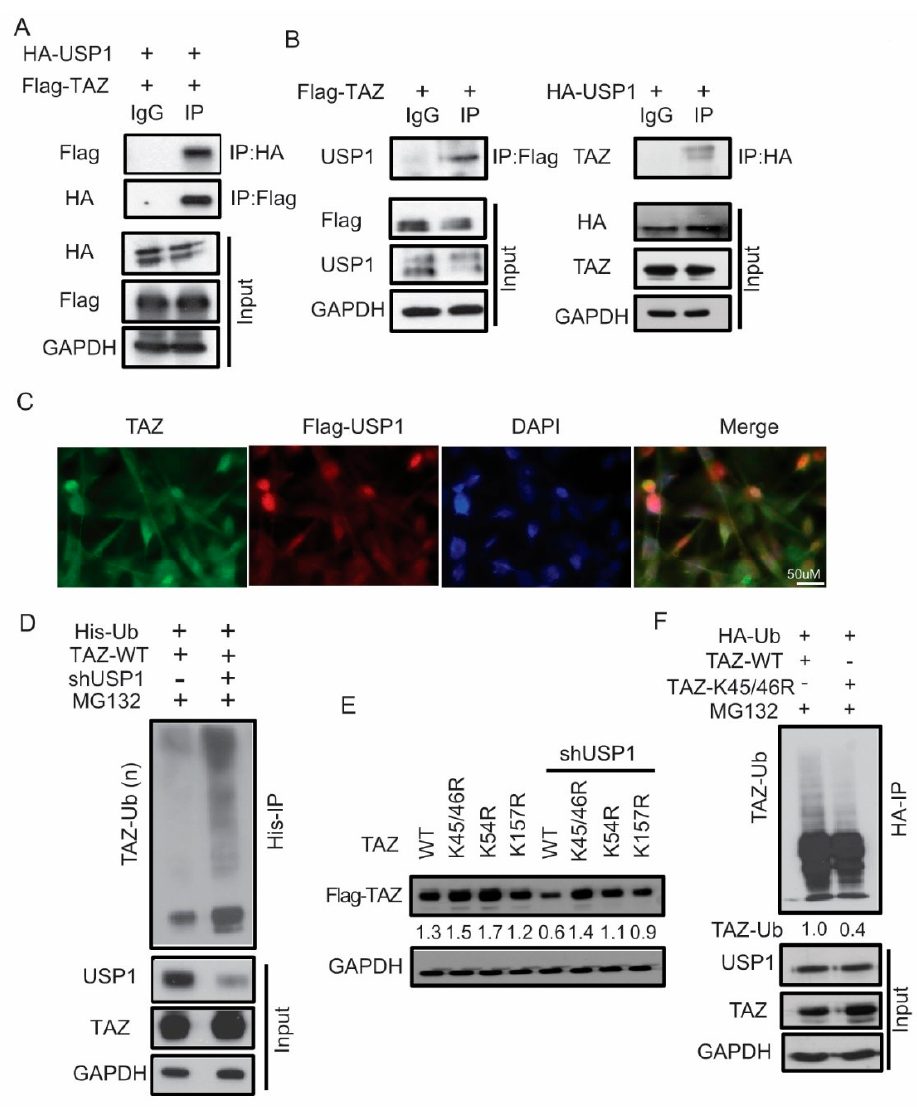
Figure 3. USP1 and TAZ form a complex and alters TAZ ubiquitination. ( A ) Interaction between exogenous USP1 and TAZ in 293T cells. Cellular extracts were immunoprecipitated with Flag or HA beads and probed for antibodies against indicated proteins. GAPDH was used as a loading control. ( B ) Interaction between exogenous TAZ and endogenous USP1 or exogenous USP1 and endogenous TAZ. GAPDH was used as a loading control. ( C ) Immunofluorescence staining of Flag-USP1 and TAZ in MDA-MB-231 cells (Scale bar = 50 µ m). ( D ) Increased ubiquitination of TAZ upon knockdown of USP1 and immunoprecipitation with His-beads. GAPDH was used as a loading control for input. ( E ) Immunoblot analysis of TAZ-WT or lysine mutants in the presence or absence of USP1. GAPDH was used as a loading control. ( F ) Decreased ubiquitination of K45 / 46R mutation after co-immunoprecipitation with HA-beads. GAPDH was used as a loading control for input. Immunoblots were quantified and normalized to GAPDH.